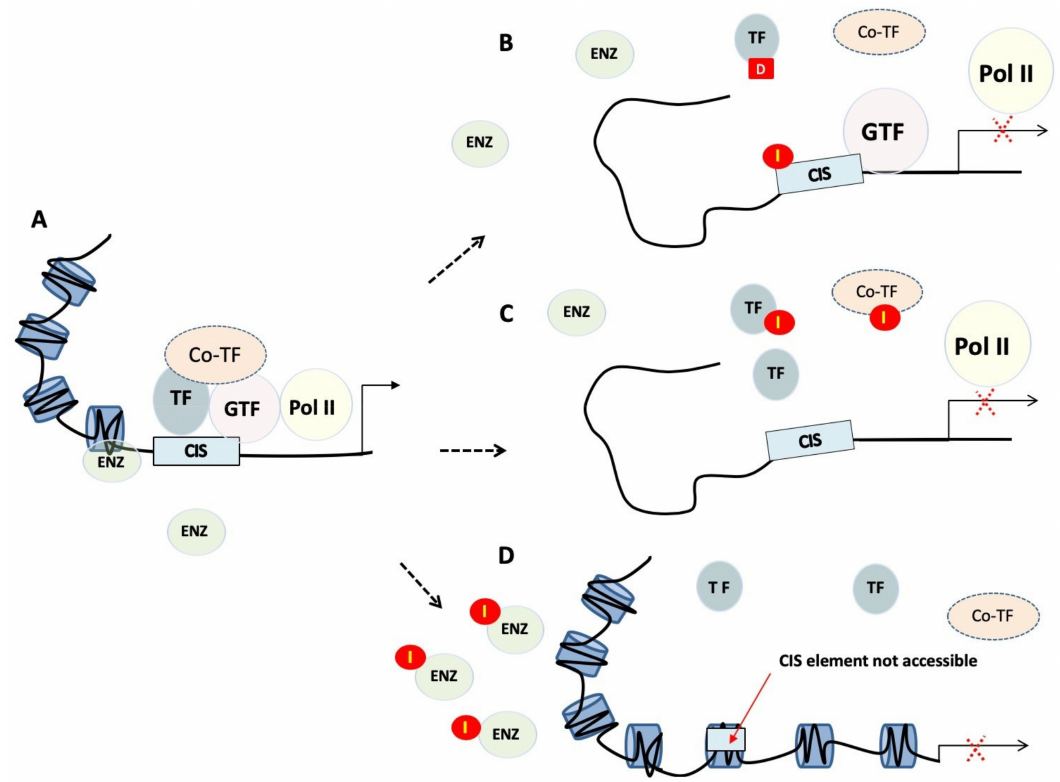
Figure 1. Transcriptional regulation and targeting strategies. ( A ) Transcriptional regulation is the means through which a cell regulates the conversion of DNA to RNA and so thereby orchestrates gene activity. RNA polymerases (Pol II), transcription factors (TF), as well as a multitude of other proteins act in concert to regulate this activity. ( B ) Small molecules or polyamides (I) compete with transcription factors binding to cis-regulatory elements, whereas decoys (D) bind transcription factors preventing them from binding to promoters. ( C ) Peptide mimetics or small molecules disrupt dimerisation of transcription factors, or interactions between transcription factors and their co-regulators. ( D ) Tight or closed chromatin is more compact and so refractory to factors that need to gain access to the DNA template. TF, transcription factor; GTF, general transcription factor; Pol II, RNA polymerase II; Co-TF, transcription co-regulator; I, inhibitor; D, transcription factor decoy; ENZ, modifying